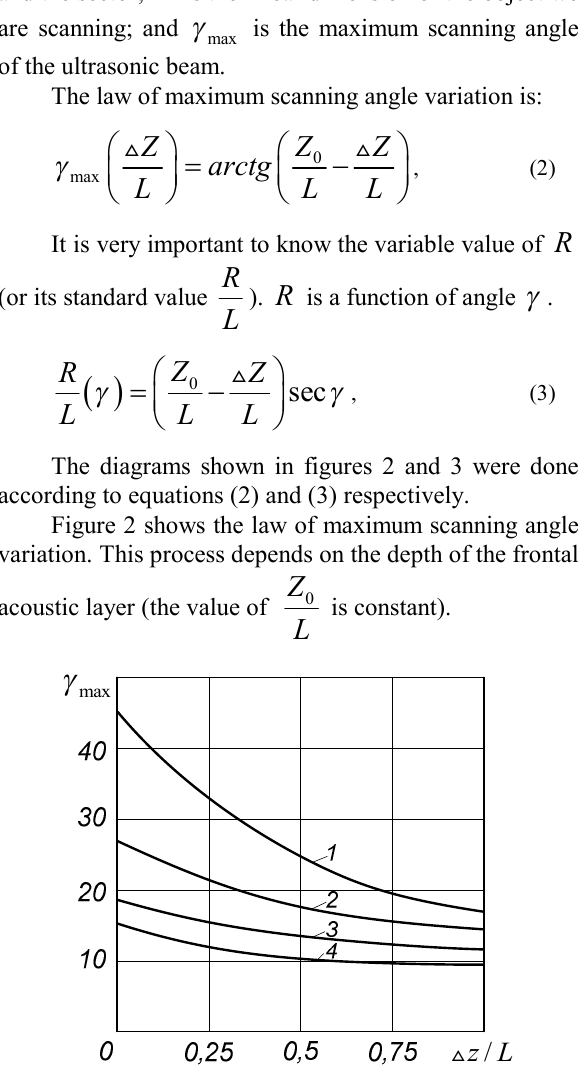
Fig 2. The dependence of maximum scanning angle on the depth of the frontal sector: 1 is 0,5; 2 is 1; 3 is 1,5; and 4 is 2